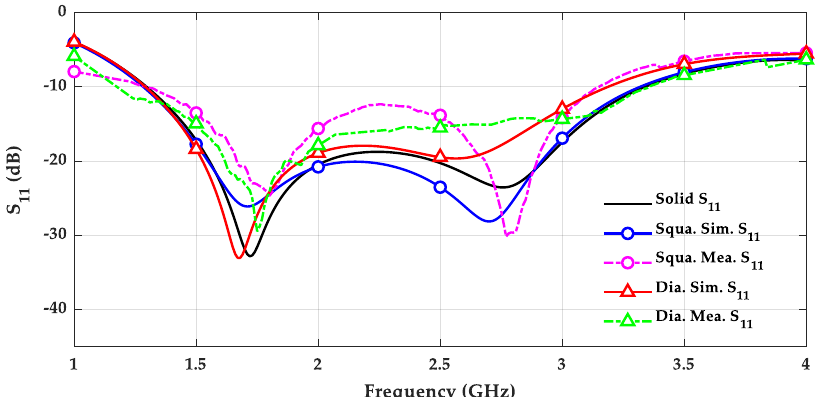
Figure 11. Simulated and measured reflection coefficients ( S 11 ) of the solid antenna, and the meshed antenna.